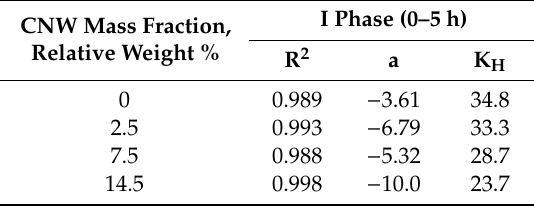
Table 2. Fitting parameters of the Higuchi model for the tetracycline-containing ALG CNW